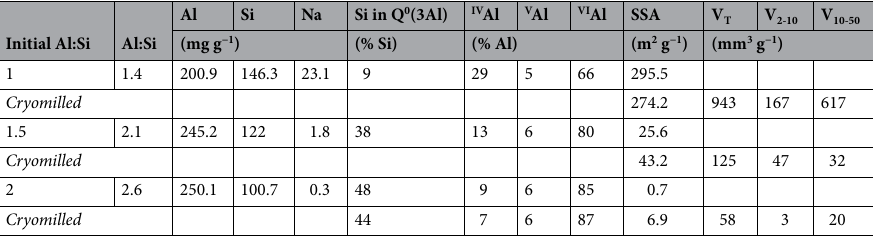
Table 1. Selected chemical and physical properties of synthesized short-range ordered aluminosilicates. Proportion of Si nuclei in imogolite-like coordination (Q 0 (3Al)) and Al nuclei in tedrahedral (Al IV ), pentahedral (Al V ) and octahedral (Al VI ) coordination was quantified by solid-state nuclear magnetic resonance spectroscopy. Specific surface area (SSA), total pore volume (V T ) and pore volume of pores with diameters from 2–10 nm